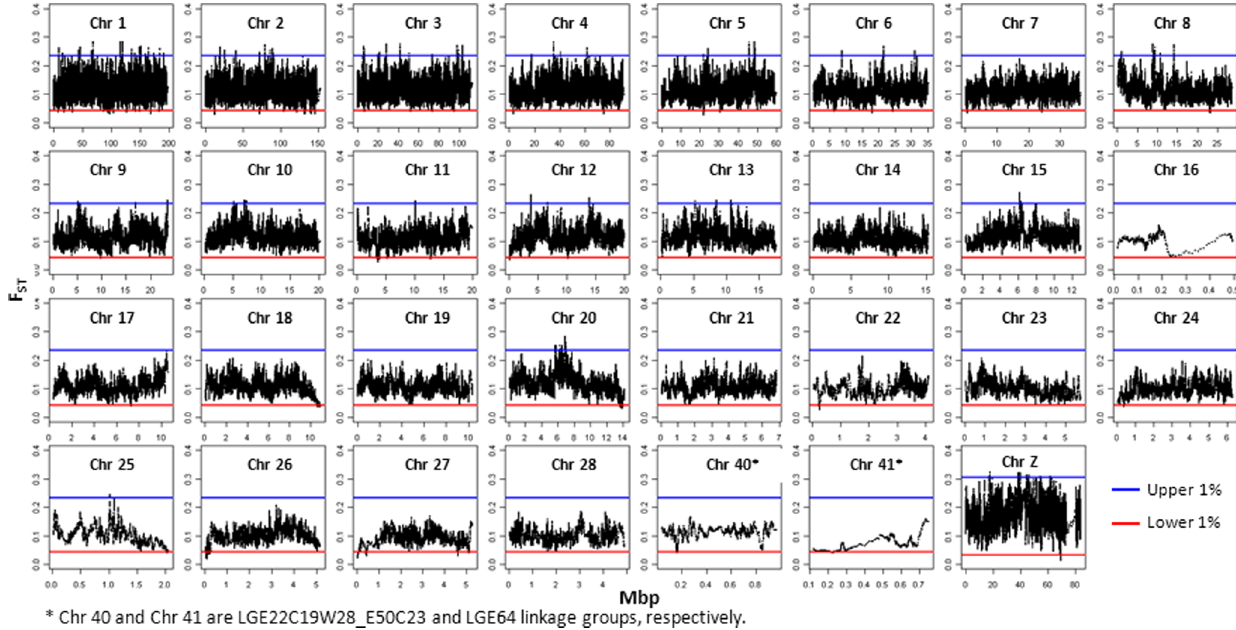
Figure 3. FST-values of overlapping windows for comparison between commercial layers and out-group. Red (blue) line indicates the upper (lower) 1% of FST distribution.